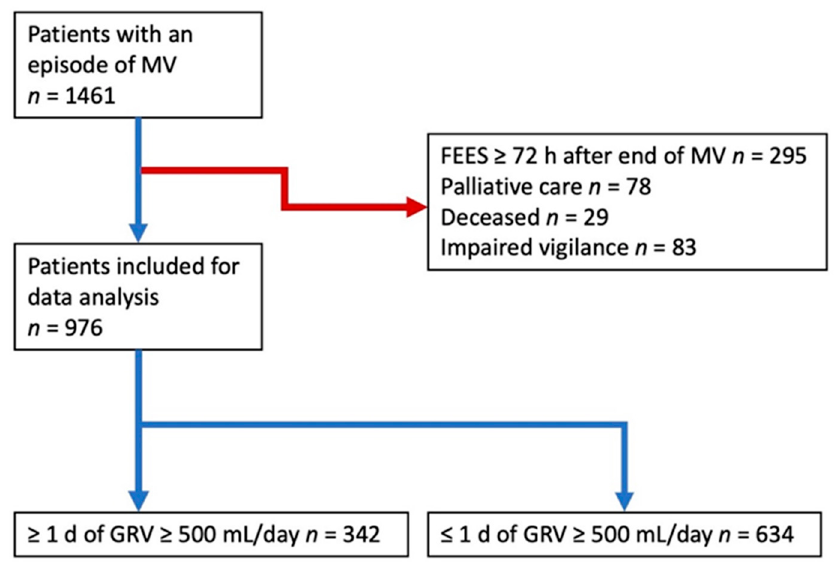
Figure 1. Recruitment flowchart; MV = mechanical ventilation; FEES = flexible endoscopic evaluation of swallowing; GRV = gastric residual volume; mL = milliliters.